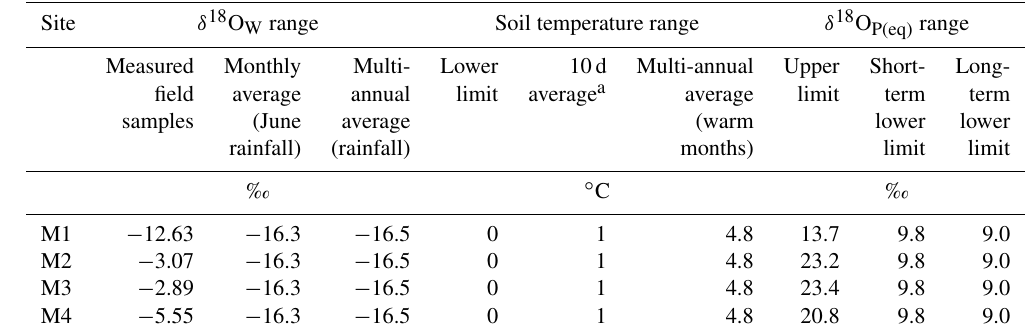
Table 2. Isotopic equilibrium values δ 18 O P(eq) calculated according to Eq. (1). “Short-term” represents the sampling period 10d equilibrium. “Long-term” represents a multi-annual equilibrium average.